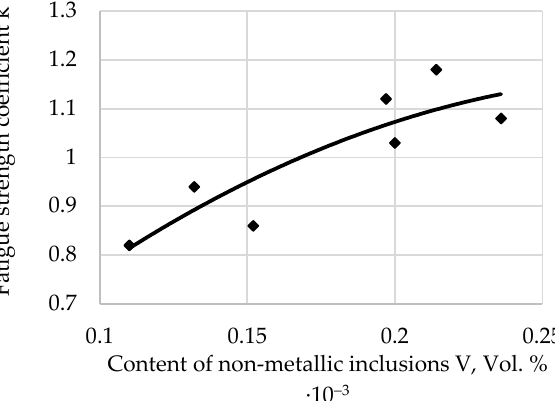
Figure 4. The bending fatigue strength coefficient, k, of research steel after hardening and tempering at 400 °C depends on the relative content of non-metallic inclusions.